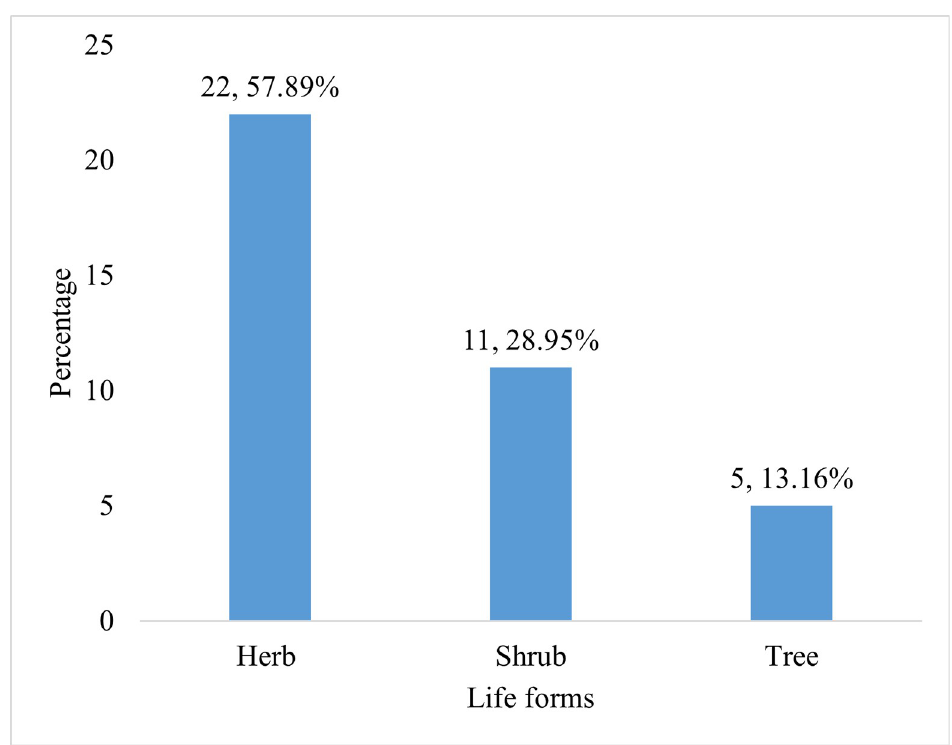
Fig 4. Percentage of distribution of poisonous plant different plant functional types (PFTs).